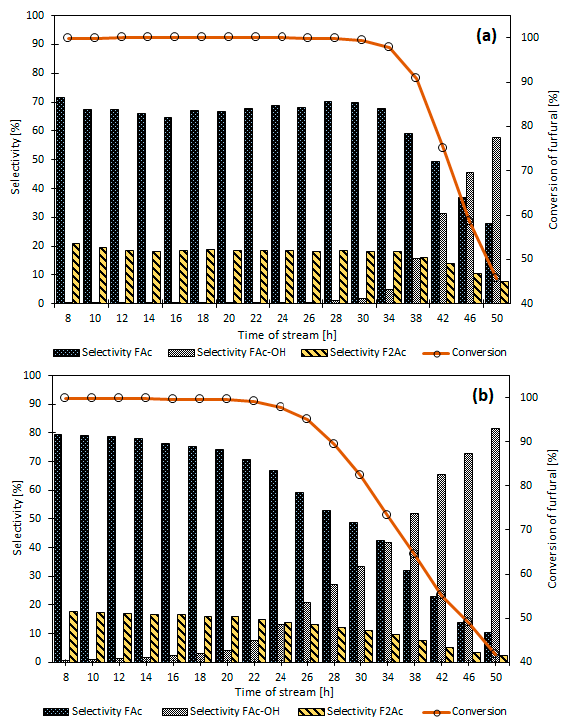
Figure 3. Aldol condensation of ( a ) furfural with acetone in molar ratio 1:2.5, ( b ) furfural with acetone in molar ratio 1:2.5 with 5 wt.% water addition. Tests were performed in a continuous-flow reactor at constant temperature 40 °C and pressure 1 MPa, flow of feedstock 10 g/h.